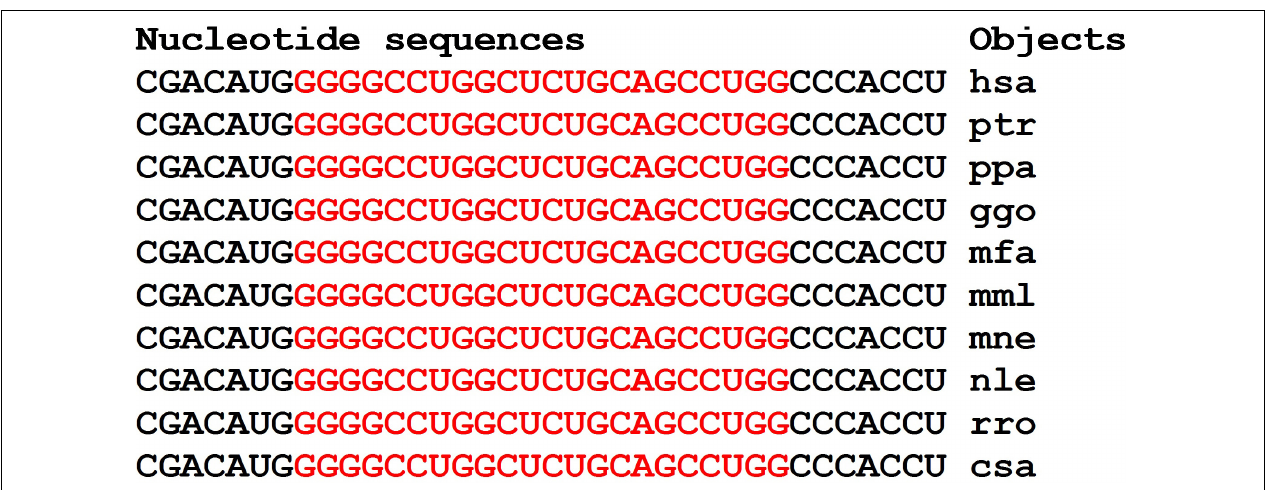
FIGURE 11 | Nucleotide sequences of the CDSs mRNAs regions of orthologous ATN1 genes containing the ID01047.3p-miR